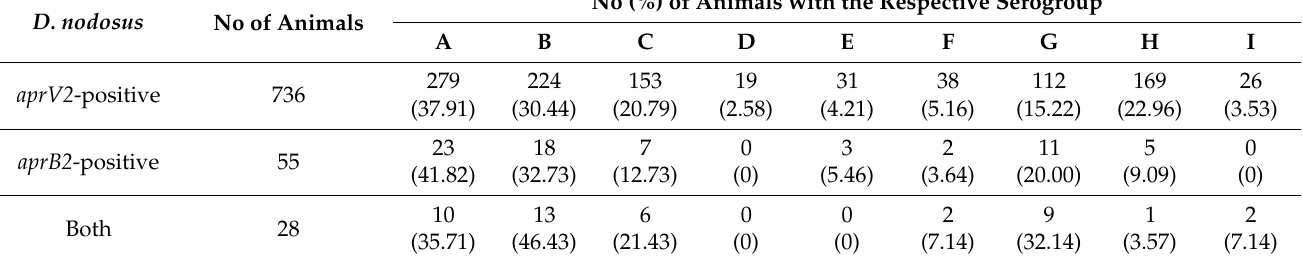
Table 1. Distribution of the serogroups in samples containing aprV2 -positive strains, aprB2 -positive strains and both strains of D. nodosus . Number (No) and percentage of animals with the respective serogroup. The percentages refer to the number of animals with the serogroups and the respective strain ( n = 819).